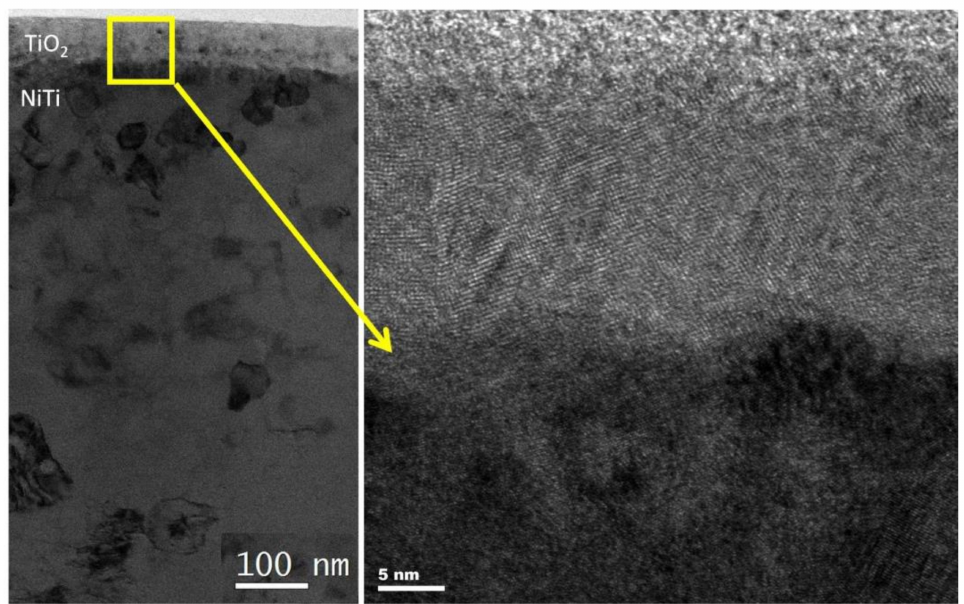
Figure 3. TEM microstructure of titanium oxide produced under glow discharge conditions in an argon + air reactive atmosphere (Ar/air = 1/4) with initial cathodic sputtering in argon-nitrogen plasma (Ar/N 2 = 1/1).